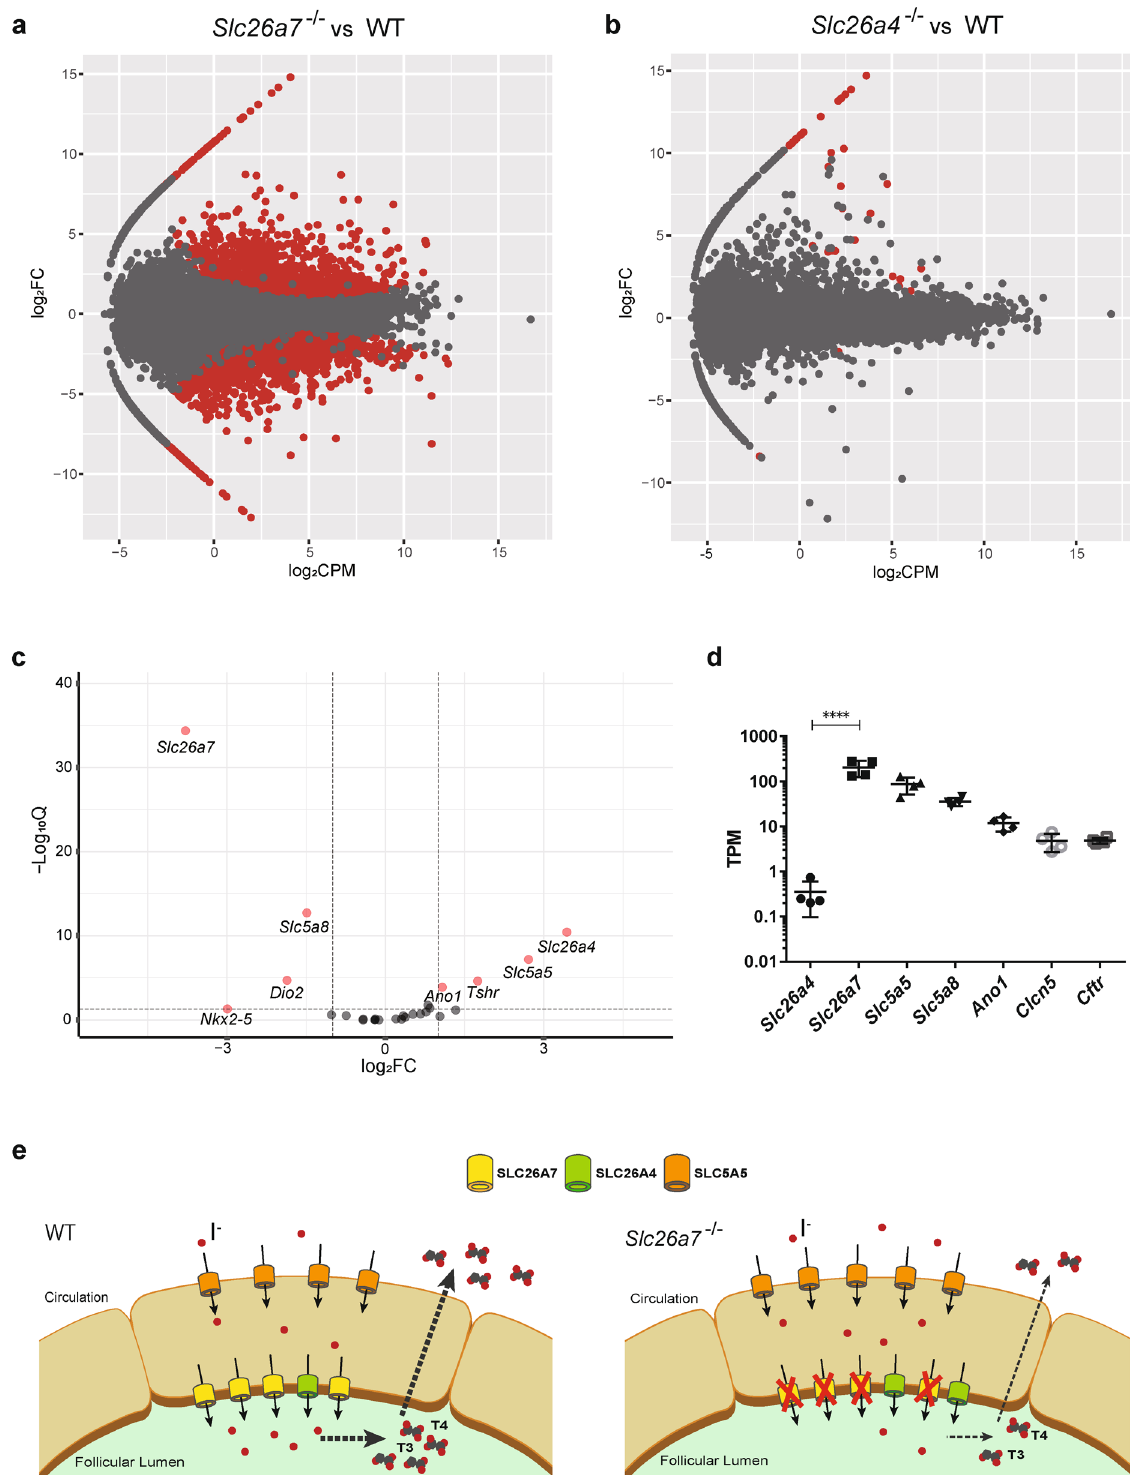
Figure 4. Gene expression profiles were greatly altered in Slc26a7 −/− mice. ( a , b ) Global patterns of gene expression in wild type (WT) (male n = 4), Slc26a7 −/− (male n = 4), and Slc26a4 −/− (male n = 3) mice are depicted using a MA plot with counts per million (CPM) and fold change (FC). Genes with a Q -value < 0.05 are indicated by red dots. The number of differentially expressed genes (DEGs) between WT and Slc26a7 −/− was 6371, and that between WT and Slc26a4 −/− was 37. ( c ) Pattern of expression of genes related to thyroid hormone synthesis is depicted using a volcano plot with FC and Q -value. Genes with ≥ 2-fold change and Q -value < 0.05 are indicated by pink dots. ( d ) Expression levels of the genes known to encode iodide transporters in male WT mice (n = 4) using the transcripts per million (TPM) value obtained by StringTie. One-way analysis of variance (ANOVA) showed significant differences among the seven groups ( F (6, 21) = 20.0, p < 0.0001). **** p < 0.0001 determined by Tukey’s test. ( e ) Schema of the relationship between Slc26a7 and Slc26a4 in the thyroid follicular cell, as deduced from the results of this study. WT wild type, CPM counts per million, FC fold change, T3 triiodothyronine, T4 thyroxine, I −